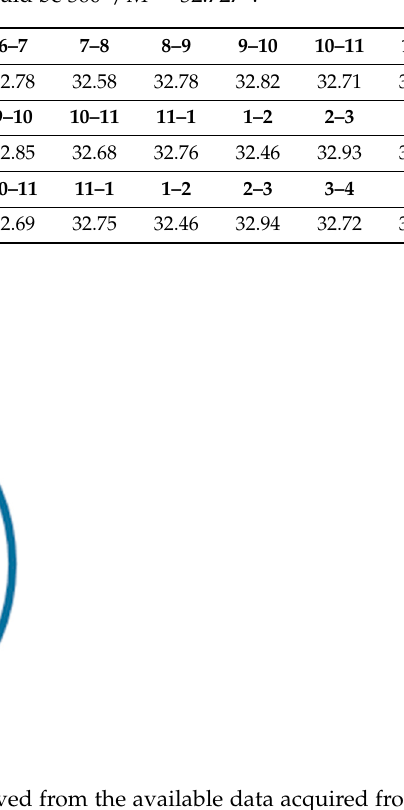
Table 2. Precise angle ( ◦ ) between consecutive blades estimated from the three different probes. The minimum estimate accuracy is ± 0.07 ◦ . The ideal would be 360 ◦ / M = 32.727 ◦ .